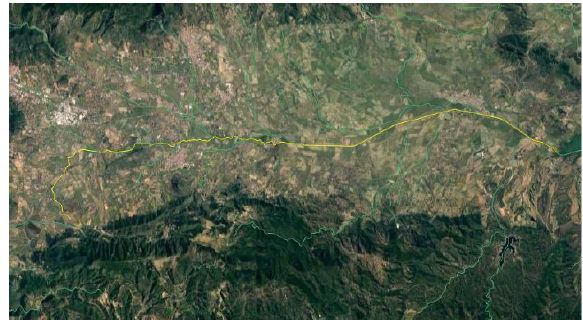
Fig. 1. Satellite framing of the investigated trait of Cixerri river with GIS data used. Fig. 2. Food web schematisation for a Mediterranean river (Grechi et al., 2016).